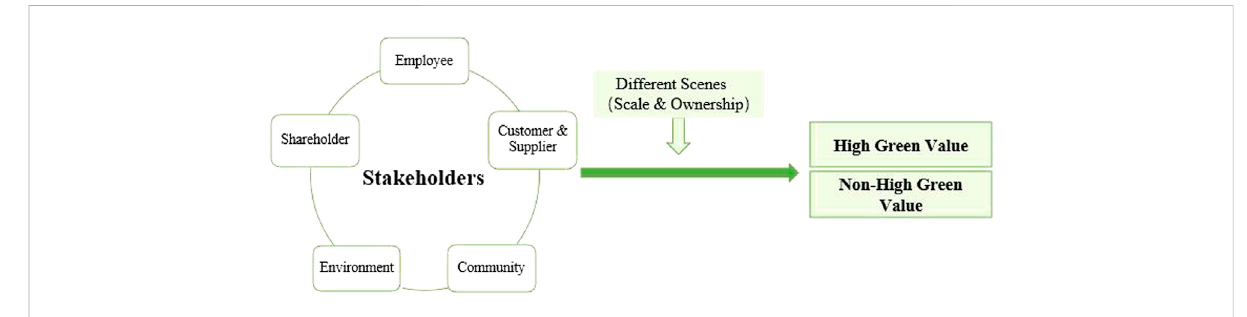
FIGURE 1 The driving mode of green value realization of fi nancial